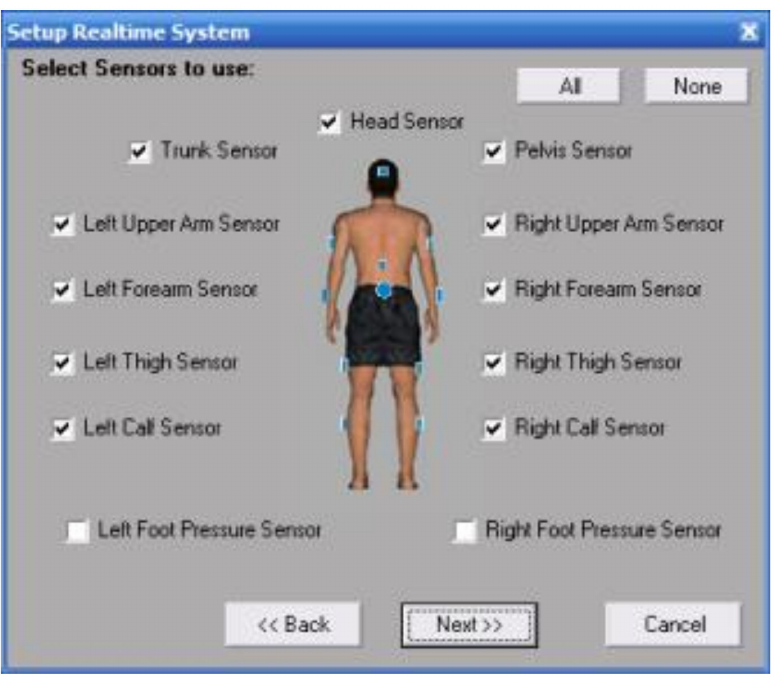
Figure 2. The working interface of the